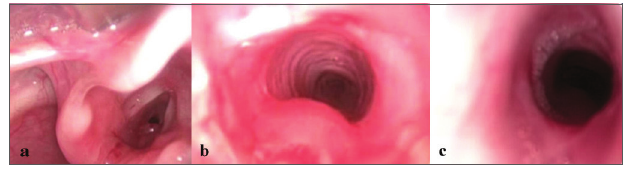
Figura 3. Paciente com estenose subglótica Grau 3 com tecido de granulação (3A), tendo sido submetido à laringoplastia com balão (3B - imagem imediatamente após a dilatação e 3C - imagem 2 semanas após o procedimento, com estenose residual Grau 1